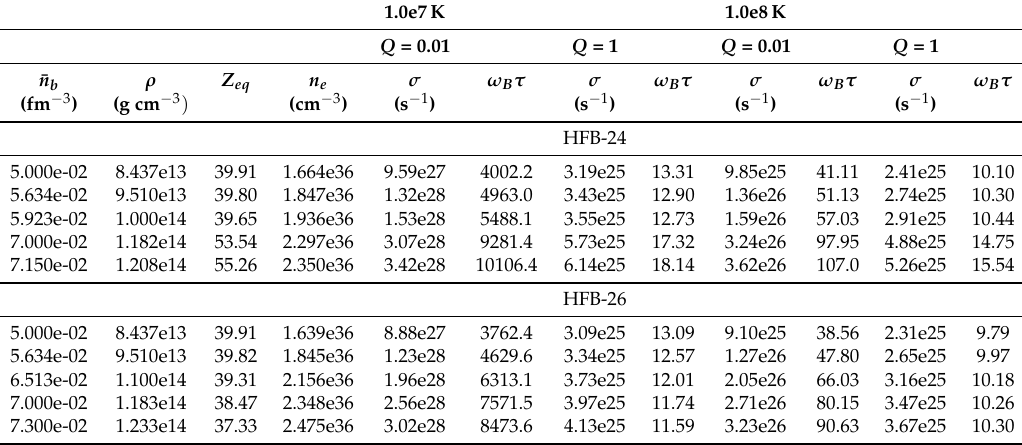
Table 5. Comparison of the nuclear mass models HFB-24 and HFB-26 in the higher matter-density layers. The third column denotes the computed equilibrium proton number, and the other parameters are the same as in Table 3. 1.0e7K